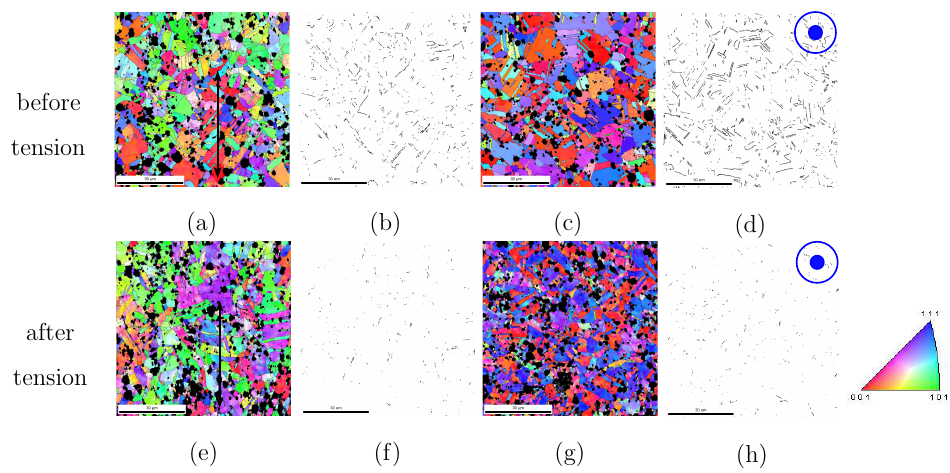
Fig. 2: The Σ3-twins in PM12-3 composite from EBSD measurements: (a)-(d) after extrusion before tenion; (a) in the longitudinal direction with the arrow presenting the extrusion direction [13]; (b) Σ3-twin boundaries in (a); (c) in the transverse direction [13]; (d) Σ3-twin boundaries in (c); (e)-(h) analogous to (a)-(d), but at the material status after tension.